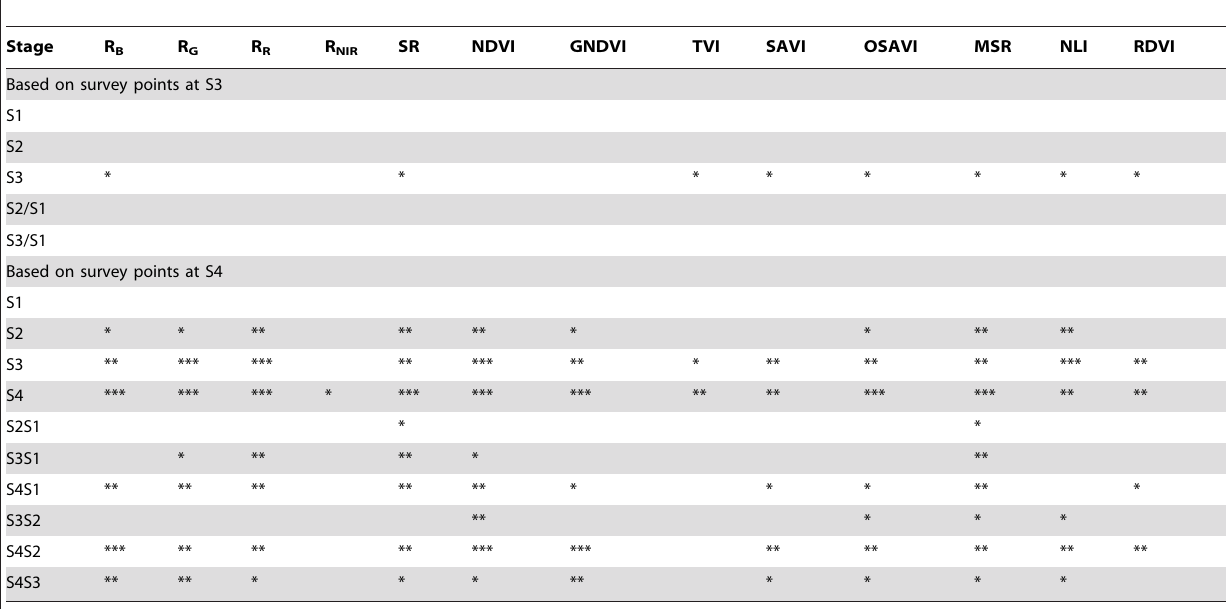
*indicates difference is significant at p -value = 0.05; ** indicates difference is significant at p -value = 0.01; *** indicates difference is significant at p -value = 0.001. ‘‘S’’ is short form for ‘‘stage’’. The multi-stage form of spectral features were calculated using a normalization process, e.g., S2S1 represents ( SpectralFeature S2 -